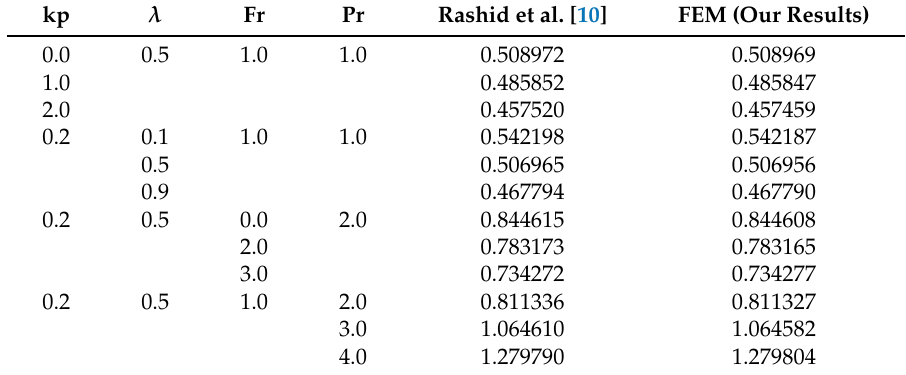
Table 2. Comparison of Nusselt number − θ (cid:48) ( 0 ) for kp, λ , Fr, and Pr at ξ = 1 when M = We = 0, Nt = Nb = 0, γ T = Q s = 0, and β → ∞ .